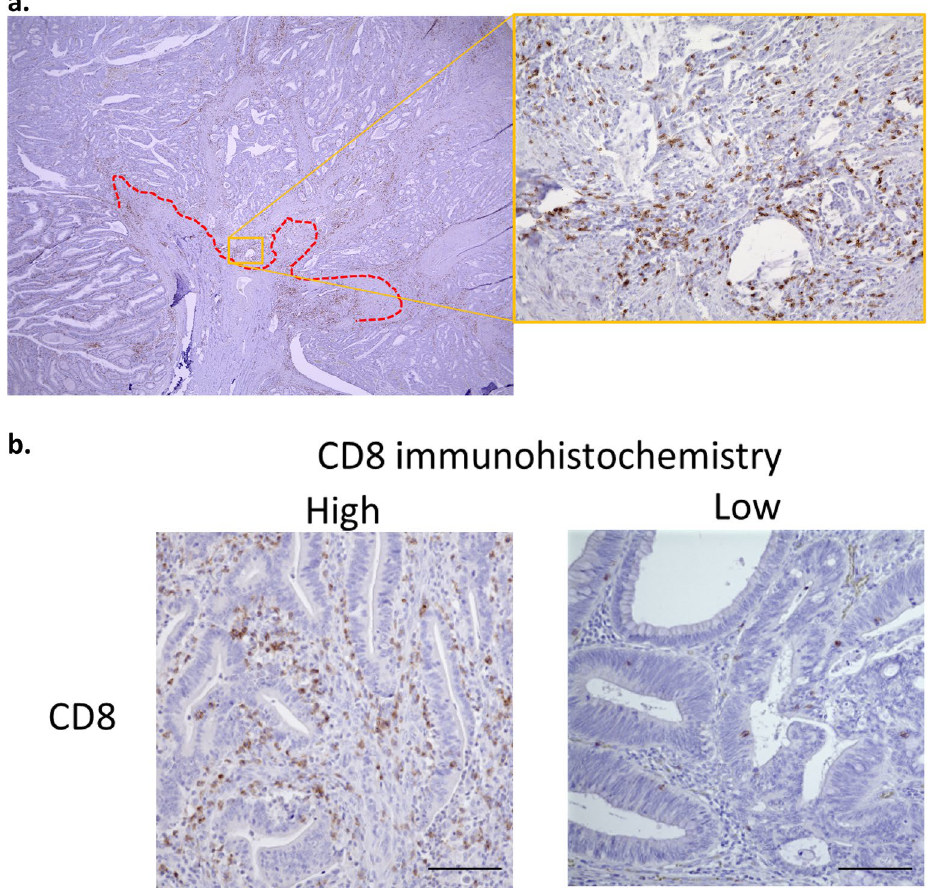
Figure 2. ( a ) The number of CD8 + TILs was counted at the invasive margin. The dotted line indicates the